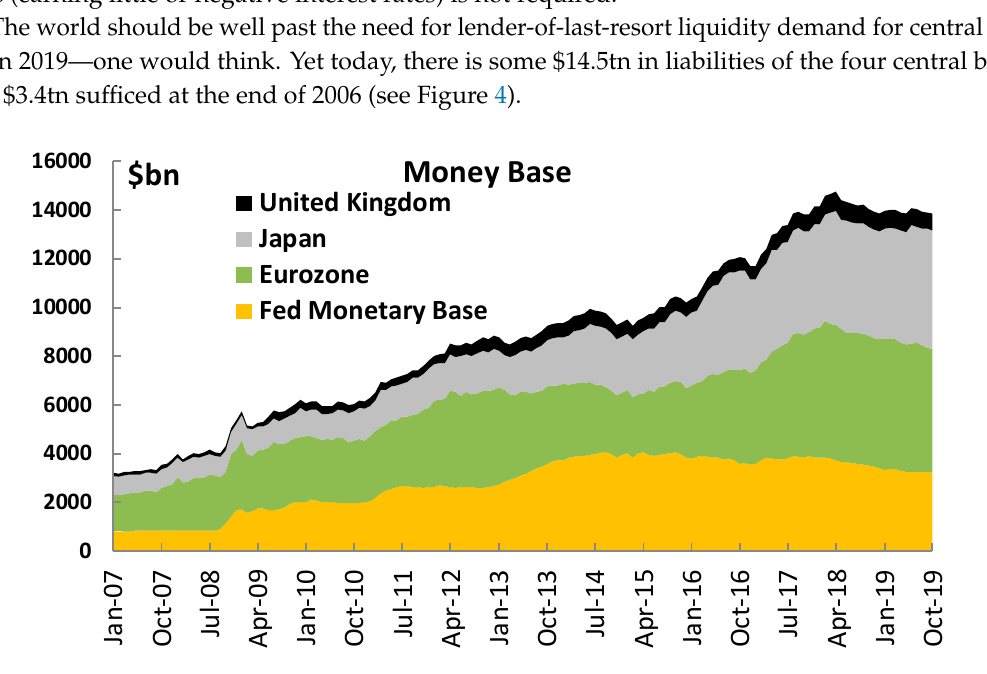
Figure 4. Money Base ($bn) by Country of Region. Source: Thomson Reuters.